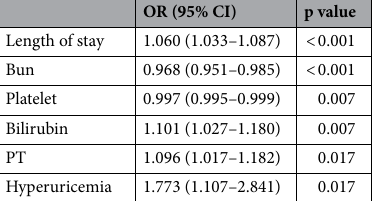
Table 4. Logistic regression analyses to assess risk factors associated with AKI in patients with sepsis. Bun blood urea nitrogen, PT prothrombin time.